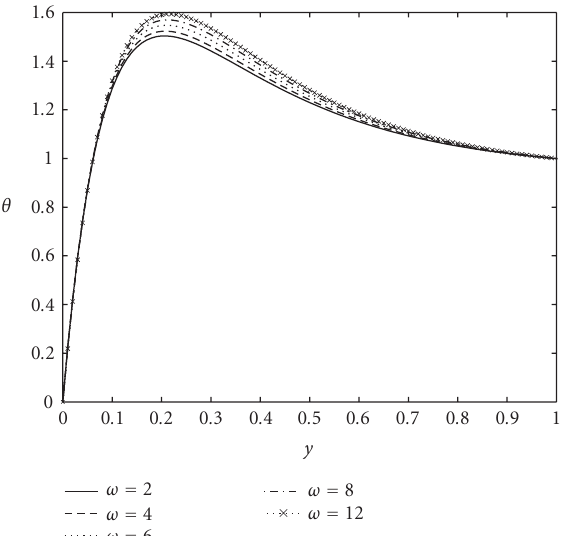
Figure 5.1. Temperature profile for Re = 5 . 0, Pr = 0 . 72, S = 1 . 0, Ec = 10 . 0, z = 0 . 5, t = 0 . 2, (cid:3) = 0 . 2.